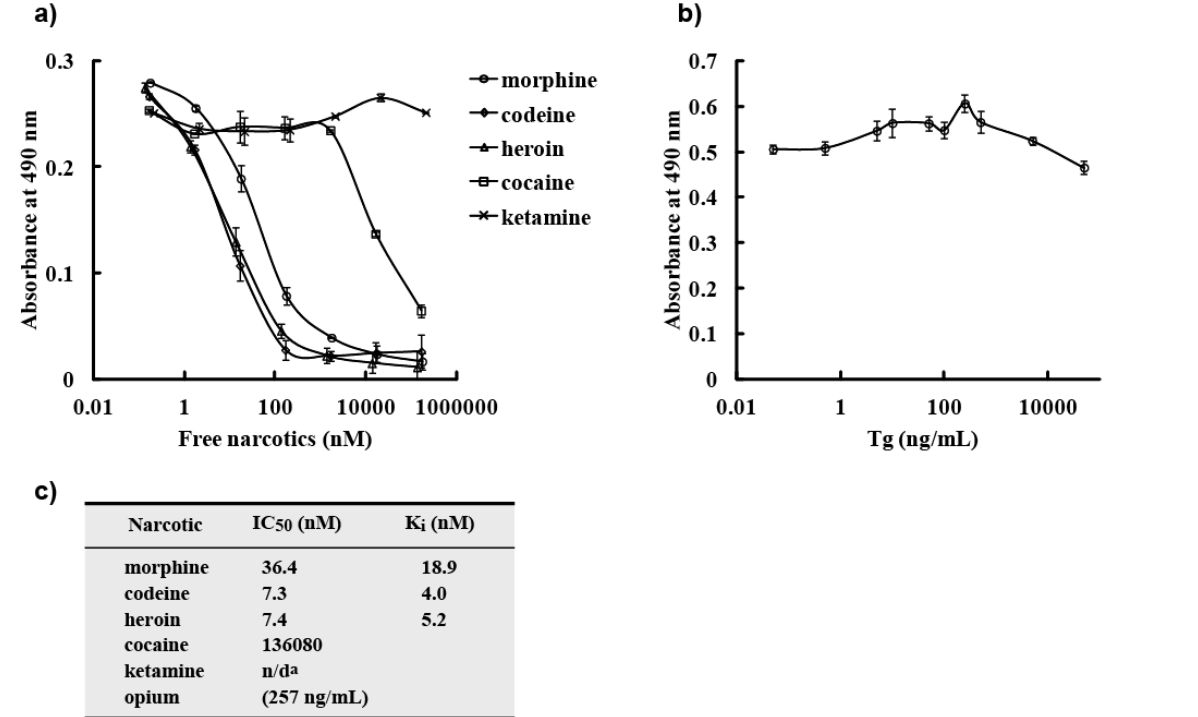
Figure 7. Competitive ELISA. ( a ) M86 binding to morphine-C-Tg was competitively inhibited by varying doses of free morphine or related compounds in ELISA. M86 (75 ng) was incubated with varying concentrations of free morphine, codeine, heroin, opium, cocaine, or ketamine and added to ELISA plates coated with 50 ng of morphine-C-Tg. M86 binding was detected using an anti-E-tag polyclonal antibody in combination with HRP-conjugated goat poly anti-rabbit IgG (H + L). All experiments were done in triplicate. ( b ) M86 binding to morphine-C-Tg was not competitively inhibited by varying doses of Tg in ELISA. The experiments were performed as described in ( a ). ( c ) Summary of IC values. IC and K values were determined using GraphPad Prism software. n/d a : could not 50 i be